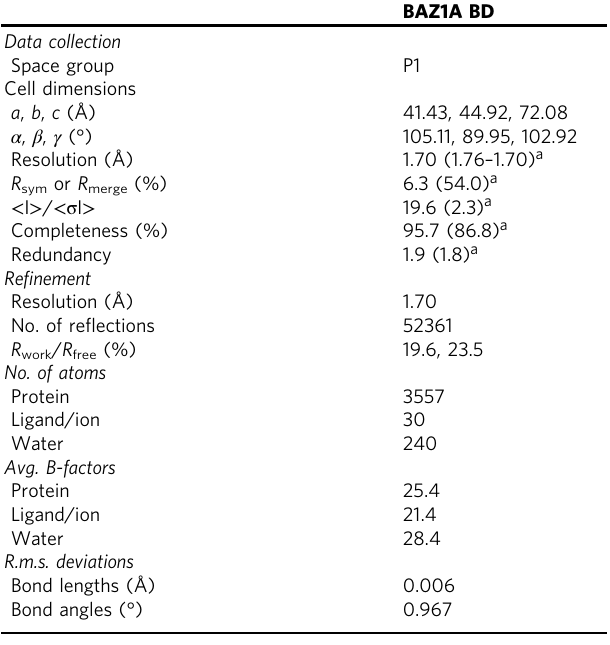
Table 1 X-ray data collection and re fi nement statistics